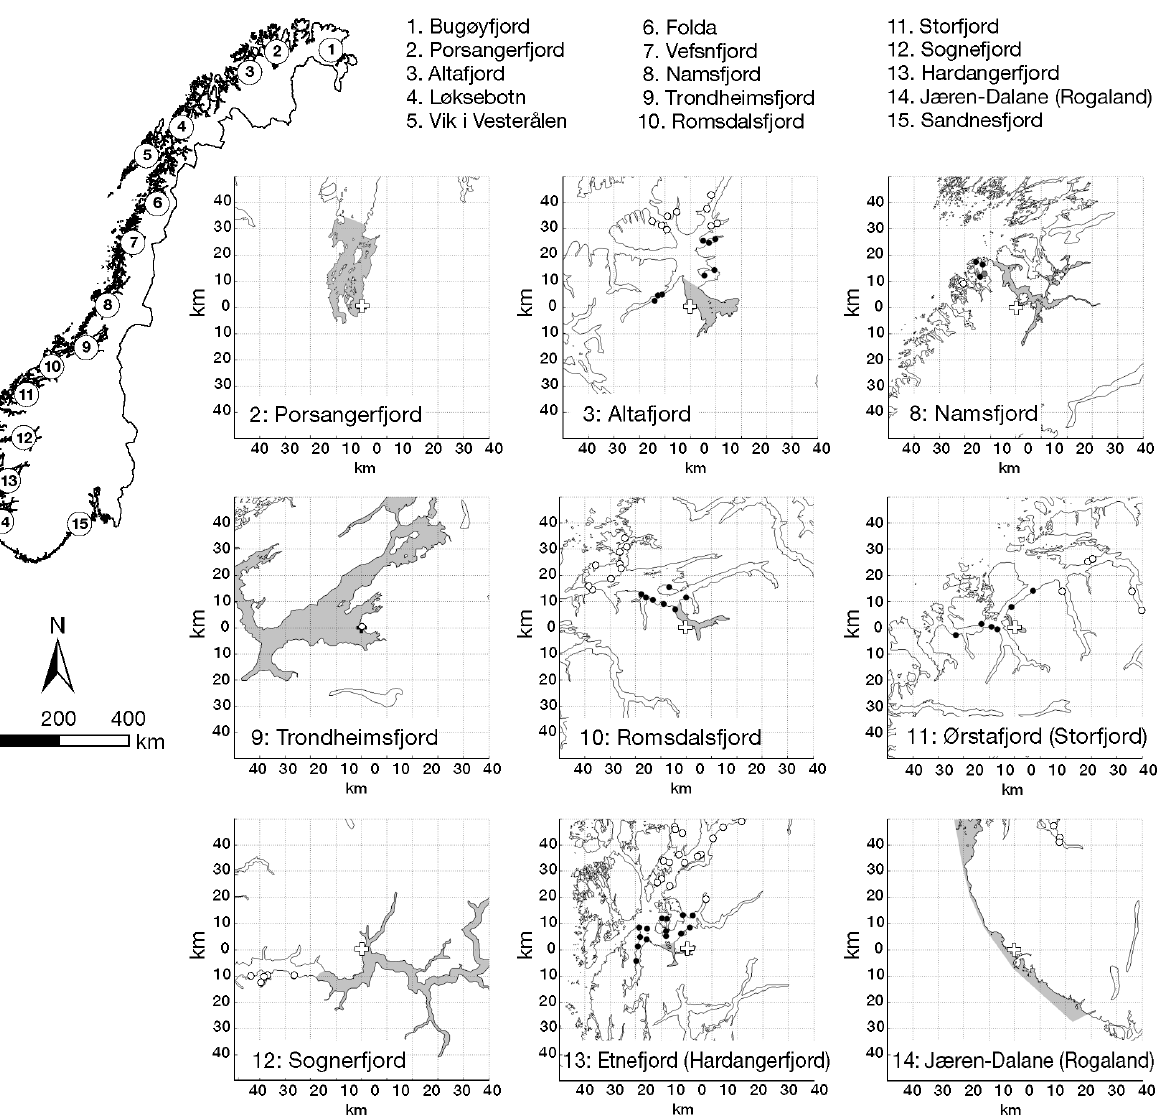
Fig. 1. Locations of all fjords included in the Norwegian national sea lice monitoring program in the period 2008 to 2012. The 9 National Salmon Fjords included in the monitoring program and evaluated in this study are shown in more detail from north to south: shaded areas indicate the extent of the protected areas; white crosses ( ) indicate the approximate sea trout sampling locations; black dots indicate salmon farms situated <30 km sea-way distance from the sea trout sampling location; white dots indicate other salmon farms (>30 km sea-way distance from the sea trout sampling location). Not all farms indicated in the maps were active during the whole study